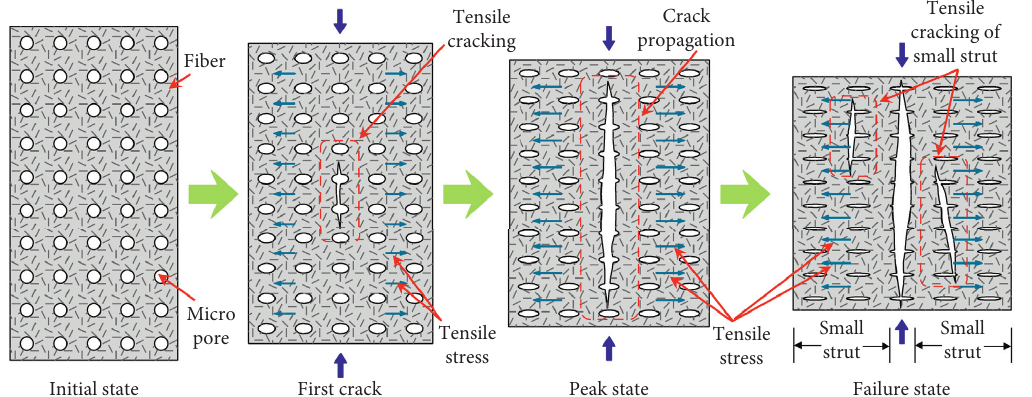
Figure 9: Damage evolution mechanism of specimens with tension failure.